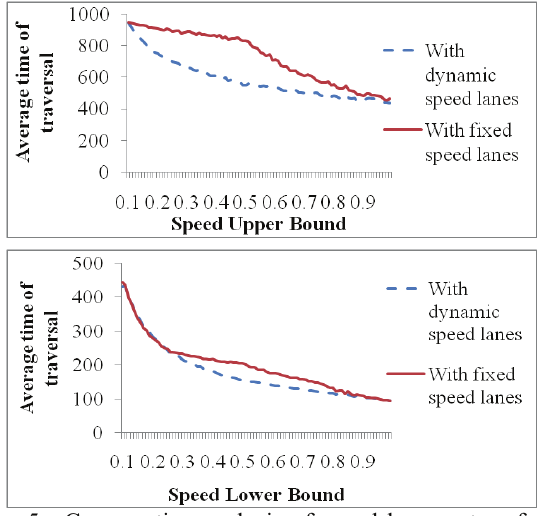
Fig. 5. Comparative analysis of speed lane system for different diversity of vehicles (a) Variable speed upper bound (b) Variable speed lower